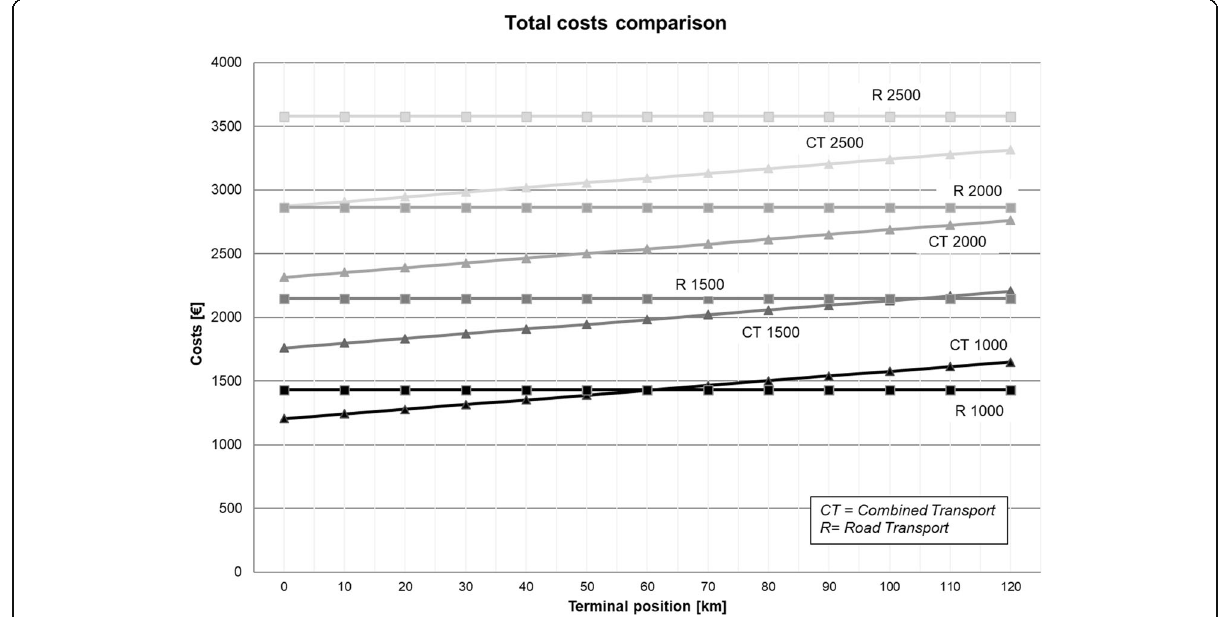
Fig. 13 Comparison of the total costs for changes in the origin-destination distance (related to the transport of one standard ITU 40 ′